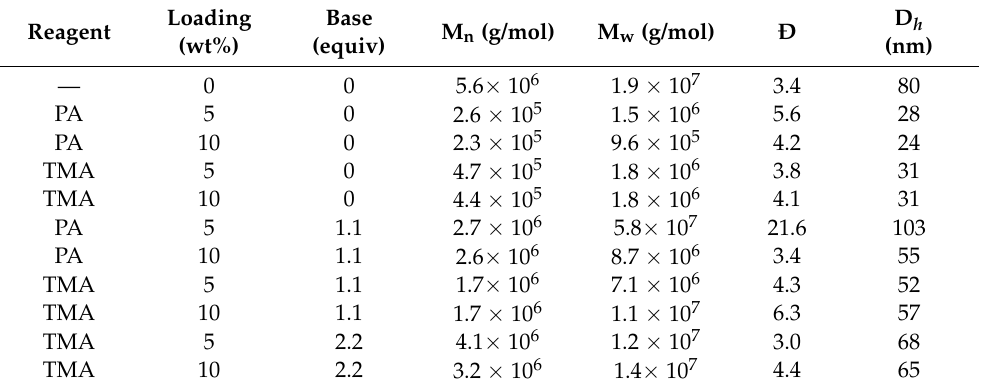
Table 3. Absolute molecular weight averages determined by GPC for starch modified with PA and TMA in a melt mixer.